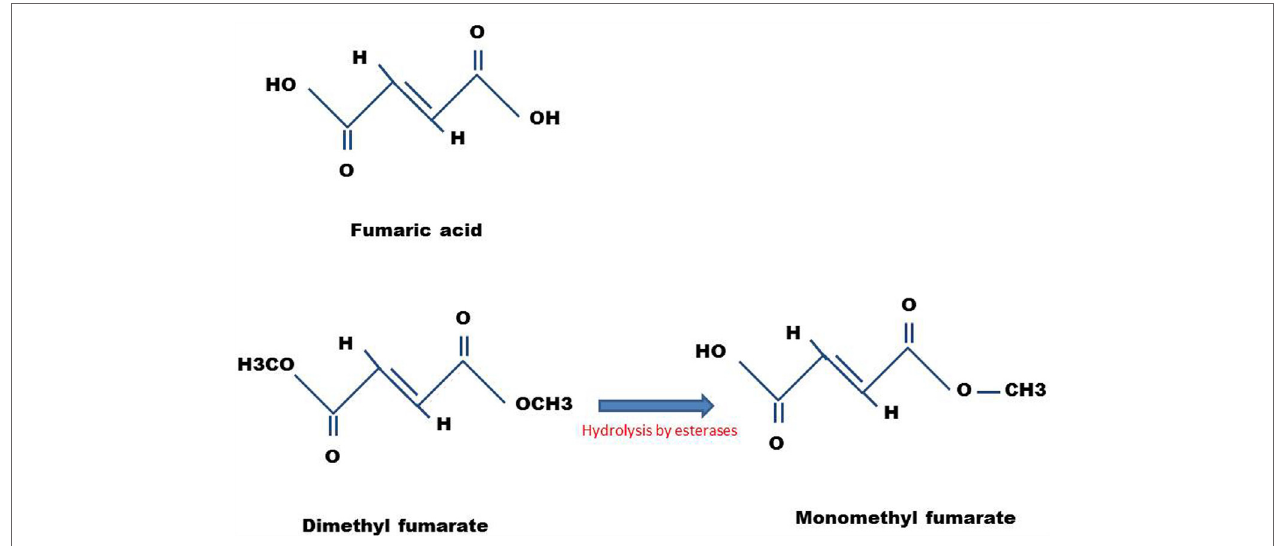
FiGURe 1 | Chemical structures of DMF and MMF . Also shown is the structure of fumaric acid, the precursor